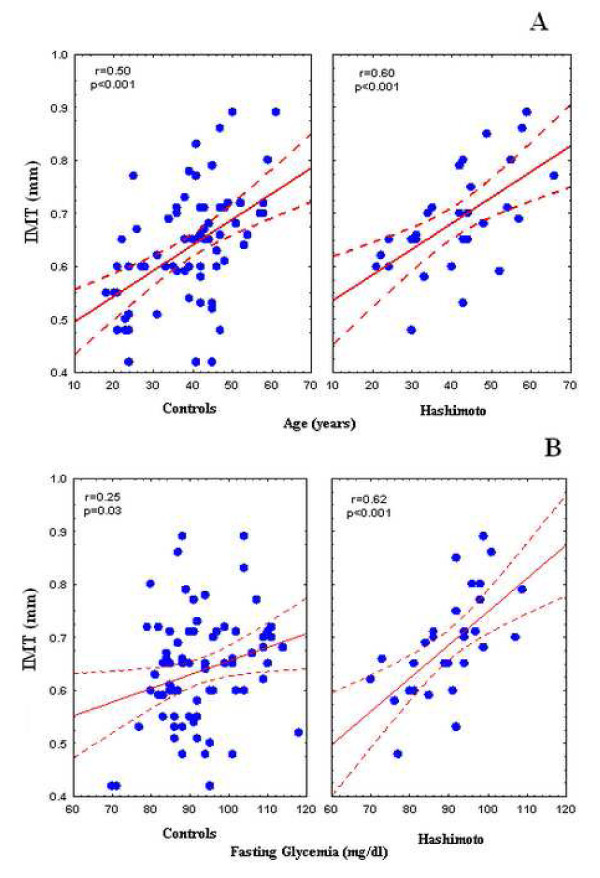
Panel A: Simple linear correlation of age and IMT in Hashimoto patients and controls; Panel B: Simple linear correlation between fasting glycemia levels and IMT in Hashimoto patients and controls.